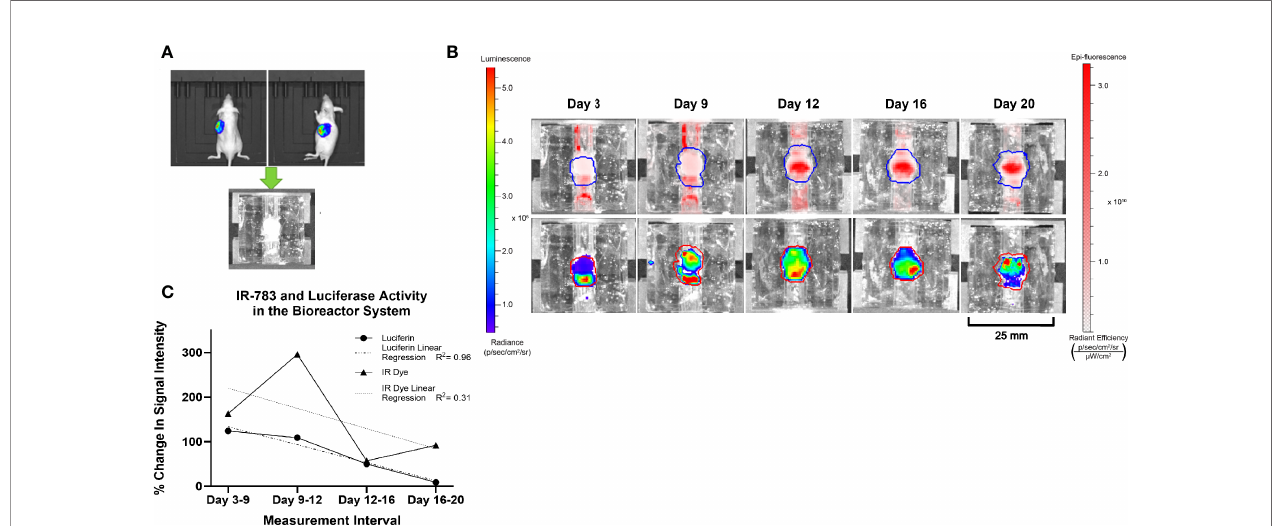
FIGURE 5 | Similar trends in the intensity of Luciferase and IR-783 imaging measurements in BON-1 xenografts. (A) BON-LUC cells were subcutaneously injected into Nu-Nu mice, tumors grown, excised, and implanted into bioreactors. (B) Radiant signal obtained post luciferin and IR-783 administration was quanti fi ed via IVIS over the course of 20 days. (C) Goodness of fi t to trendline was evaluated using simple linear regression (R 2 = 0.96 and 0.31 for Luciferase and IR-783 % change respectively). A strong positive Spearman correlation (r s = 0.77) approached but did not achieve statistical signi fi cance (p=